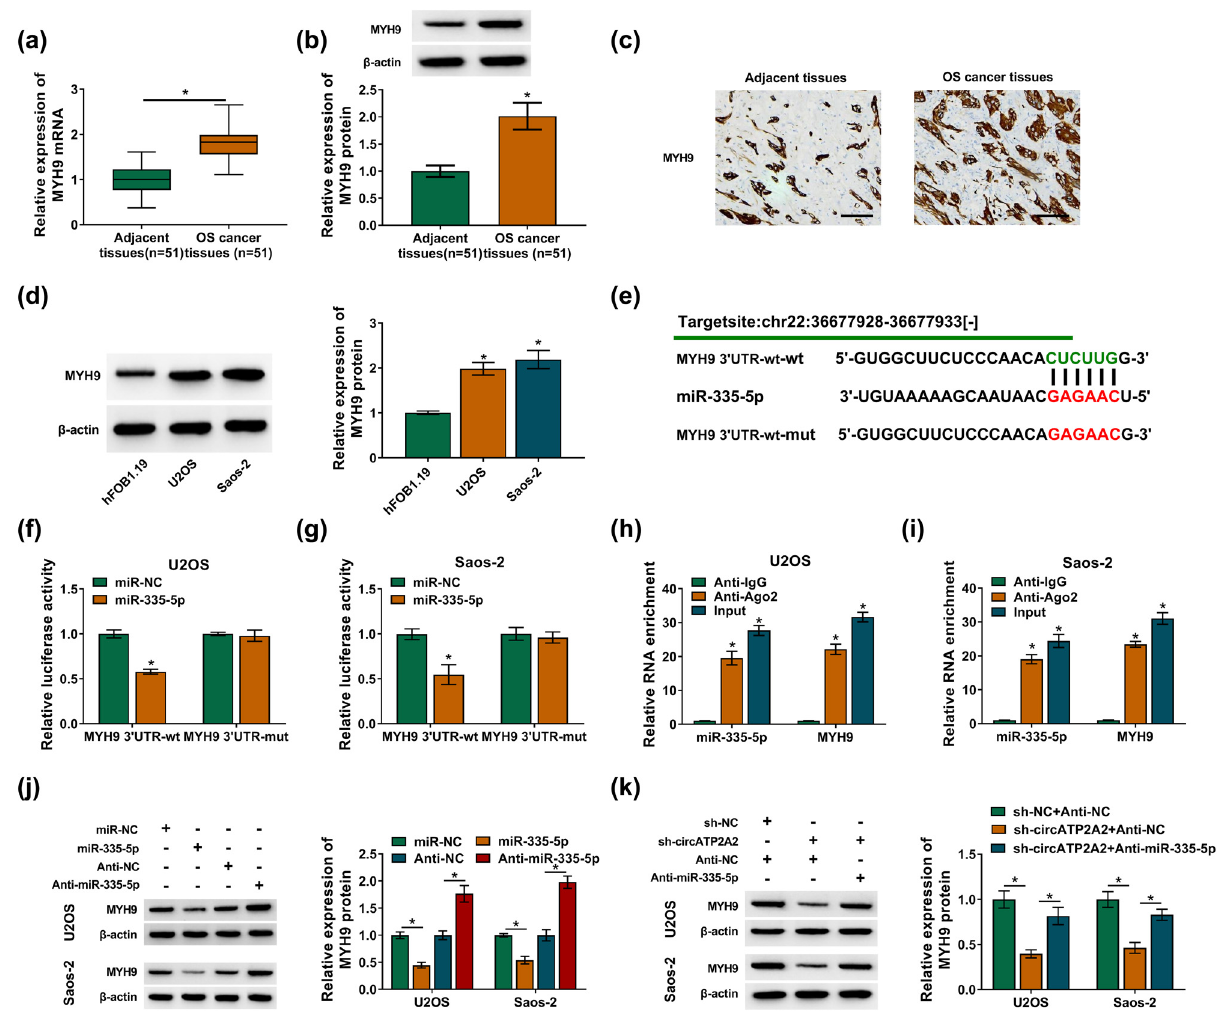
Figure 5: MiR - 335 - 5p targeted MYH9. ( a – c ) The levels of MYH9 mRNA and protein in OS tissues were analyzed by RT - qPCR, western blotting, and IHC. ( d ) The level of MYH9 protein in OS cells was analyzed by western blotting. ( e ) The binding sites between MYH9 and miR - 335 - 5p were predicted by the starBase database. ( f and g ) The luciferase activities of the reporter plasmids carrying MYH9 3 ′ UTR - wt and MYH9 3 ′ UTR - mut were determined with dual - luciferase reporter assay. ( h and i ) The abundance of miR - 335 - 5p and MYH9 in the immunoprecipitates of the anti - Ago2 and anti - IgG groups was assessed by RT - qPCR. ( j ) The impacts of miR - 335 - 5p overexpression and silencing on the level of MYH9 protein were analyzed by Western blotting. ( k ) The level of MYH9 protein in OS cells transfected with sh - NC + anti - NC, sh - circATP2A2 + anti - NC, or sh - circATP2A2 + anti - miR - 335 - 5p was detected by Western blotting. * P <